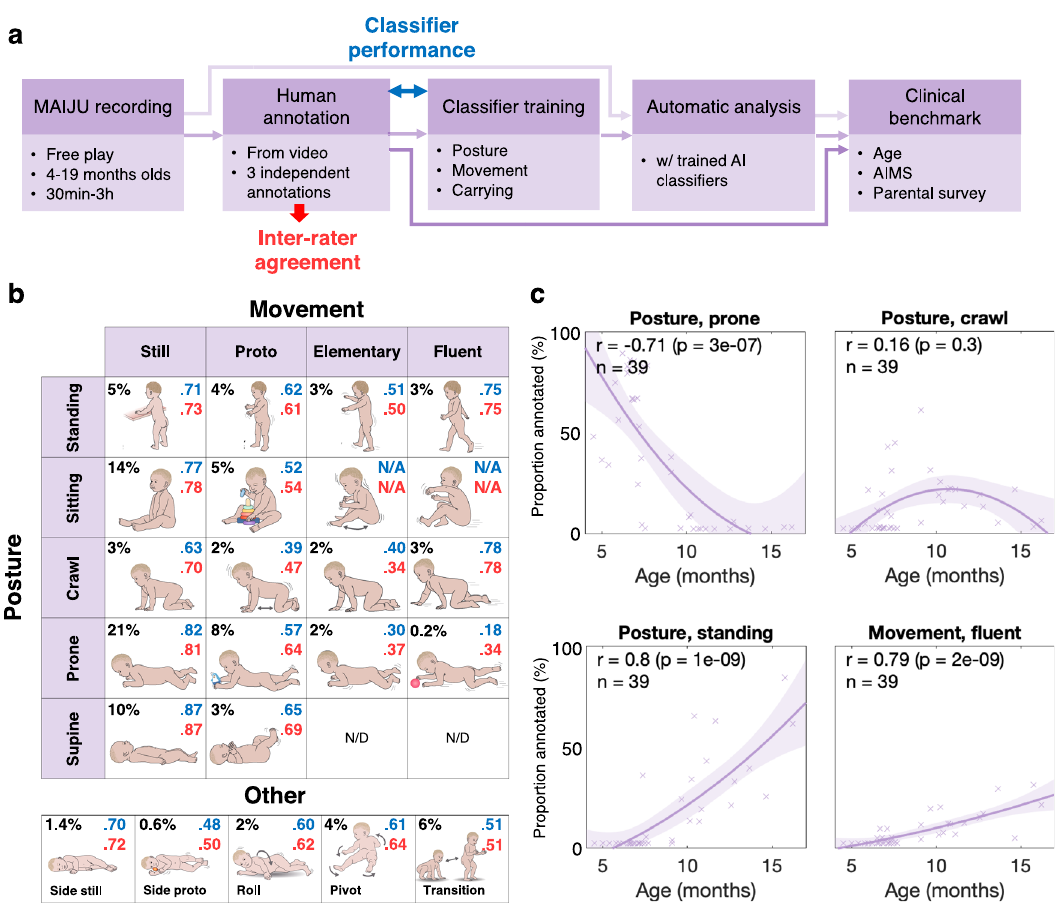
Fig. 2 Study design and the infant motor ability description scheme. a Flowchart depicting the overall study design. Coloring of the classi fi cation comparisons between humans (red) and human vs algorithm (blue) correspond to the same colors in section B. b Illustrations of the posture and movement categories identi fi ed in our motor ability description scheme. Numbers in each cell depict the proportion of each category within the annotated dataset (black), and the Fleiss ’ kappa agreement between human observers (red) or between the algorithmic analysis and human observers (blue) in the classi fi cation of 2.3-s signal frames. c Correlation between infant age and the proportions of motor ability types ( N = 42) identi fi ed from the video recordings by the human observers (individual points; the line indicates a quadratic regression model with 95% con fi dence intervals; r represents the Pearson ’ s correlation coef fi cient). Note a robust age-related decrease in prone posture, increases in standing and fl uent movement, as well as the bell- shaped developmentally transient occurrence of the crawling